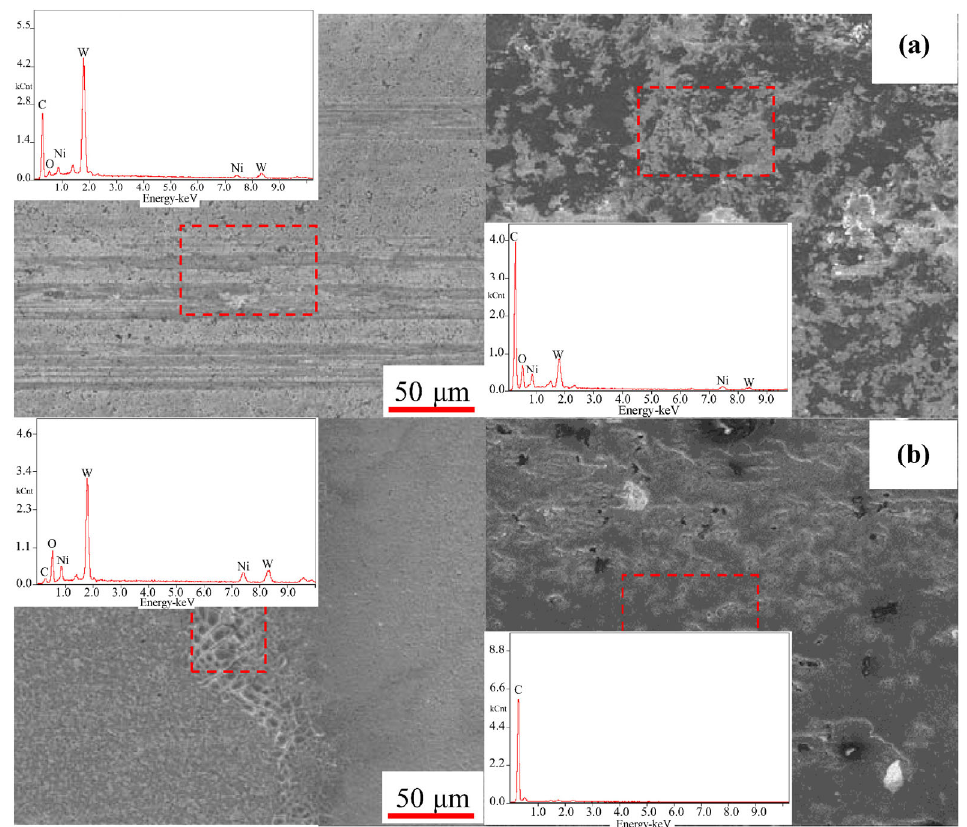
Fig. 7 SEM images of (a) non-irradiated YN6 (left) and counter graphite (right); (b) irradiated YN6 (left) and counter graphite (right). Insets were EDX spectra of marked